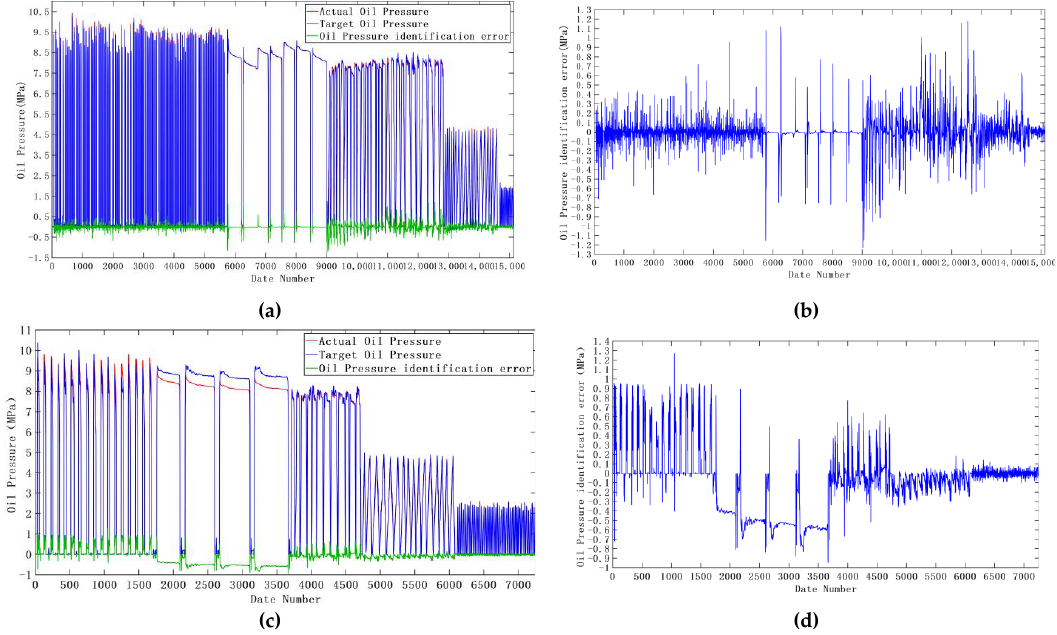
Figure 17. Oil pressure recognition results of the training set and testing set without braking conditions classification: ( a ) Actual oil pressure, target oil pressure and oil pressure identification error of training set. ( b ) Oil pressure identification error of training set. ( c ) Actual oil pressure, target oil pressure and oil pressure identification error of testing set. ( d ) Oil pressure identification error of testing